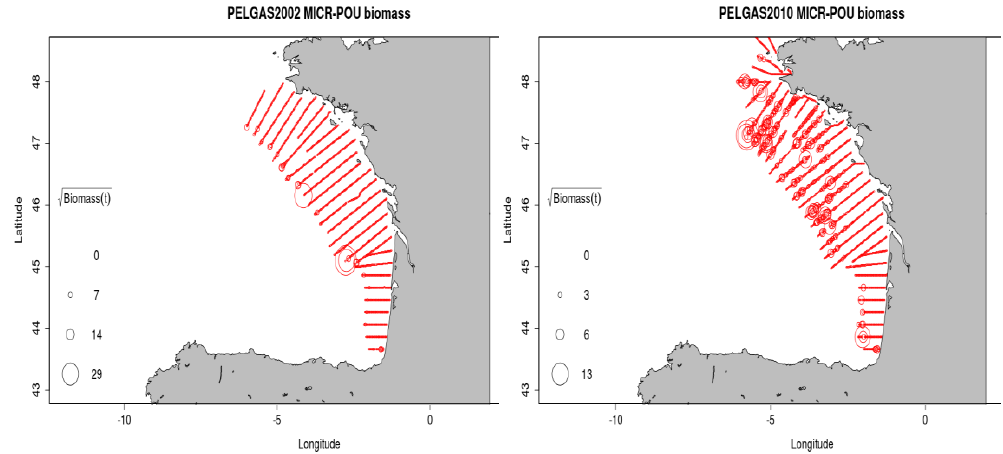
Figure 8. Blue whiting biomass estimates by EDSU from the PELGAS survey in 2002 (typical year, left) and 2010 (high biomass,